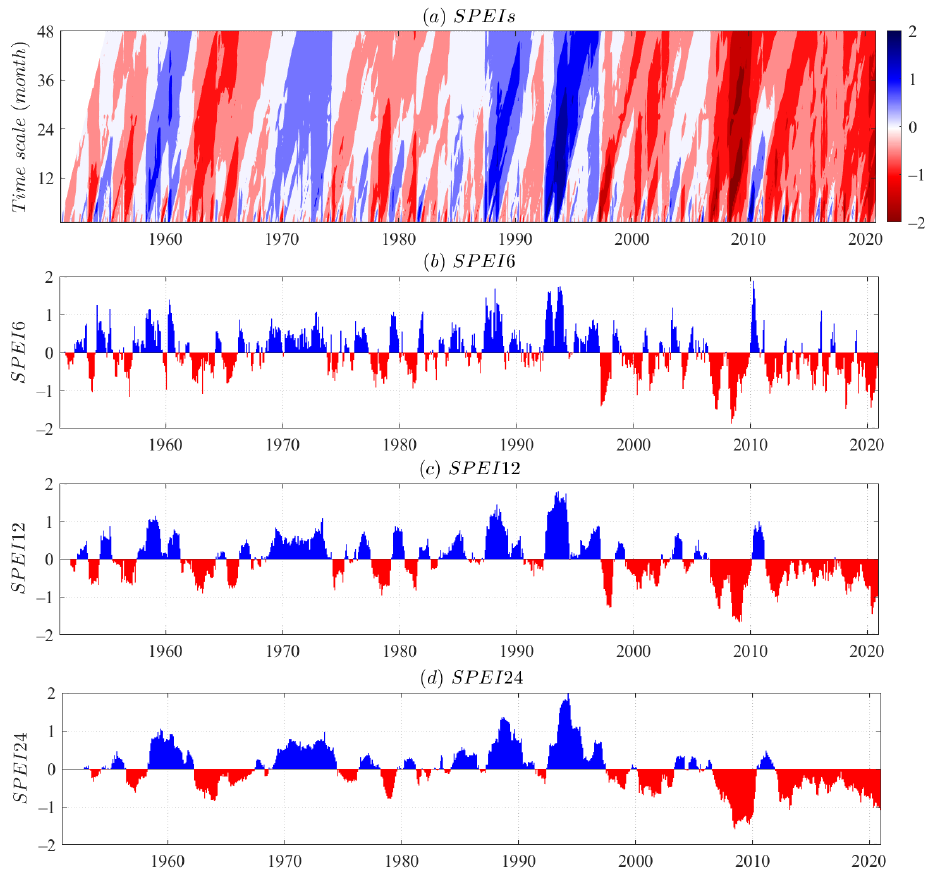
Figure 5. ( a ) Interannual variability of Standardized Precipitation Evapotranspiration Index (SPEI) at different timescales over Xinjiang, and monthly time series of ( b ) SPEI6, ( c ) SPEI12, and ( d ) SPEI24 during the period of